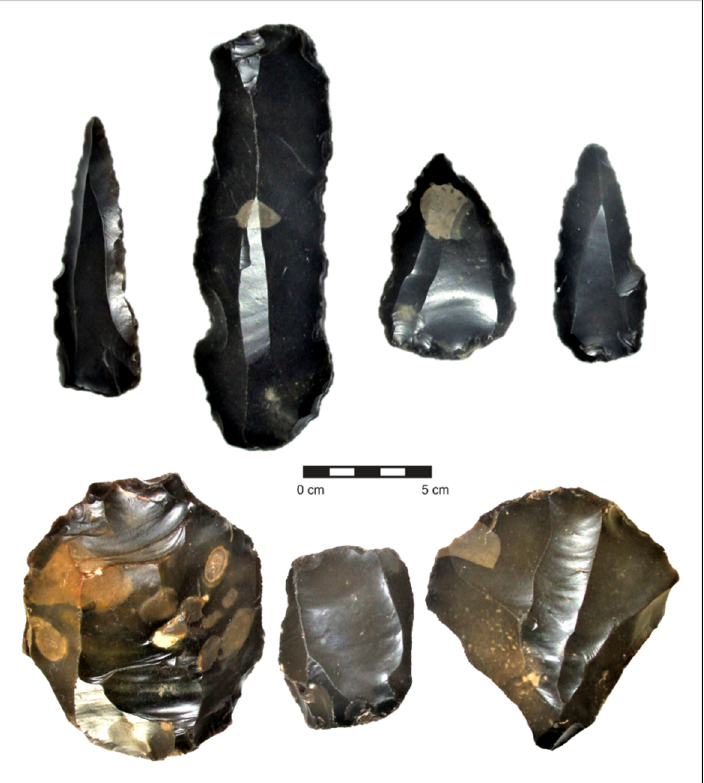
Figure 13. Mammalian teeth from the beach recharge between Clacton and Holland-on-Sea. Top row, mammoth ( Mammuthus sp.); middle, woolly rhinoceros ( Coelodonta antiquitatis ); bottom row, horse ( Equus sp.) Photos: John Ratford.